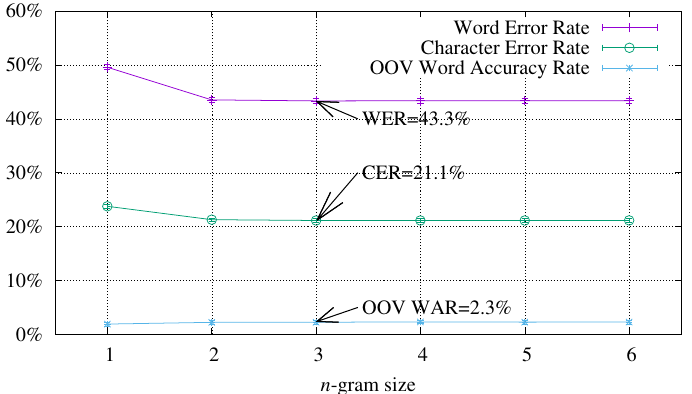
Figure 7. Results obtained by the HMM word-based system using n -gram language models with size n = { 1, . . . ,6 }